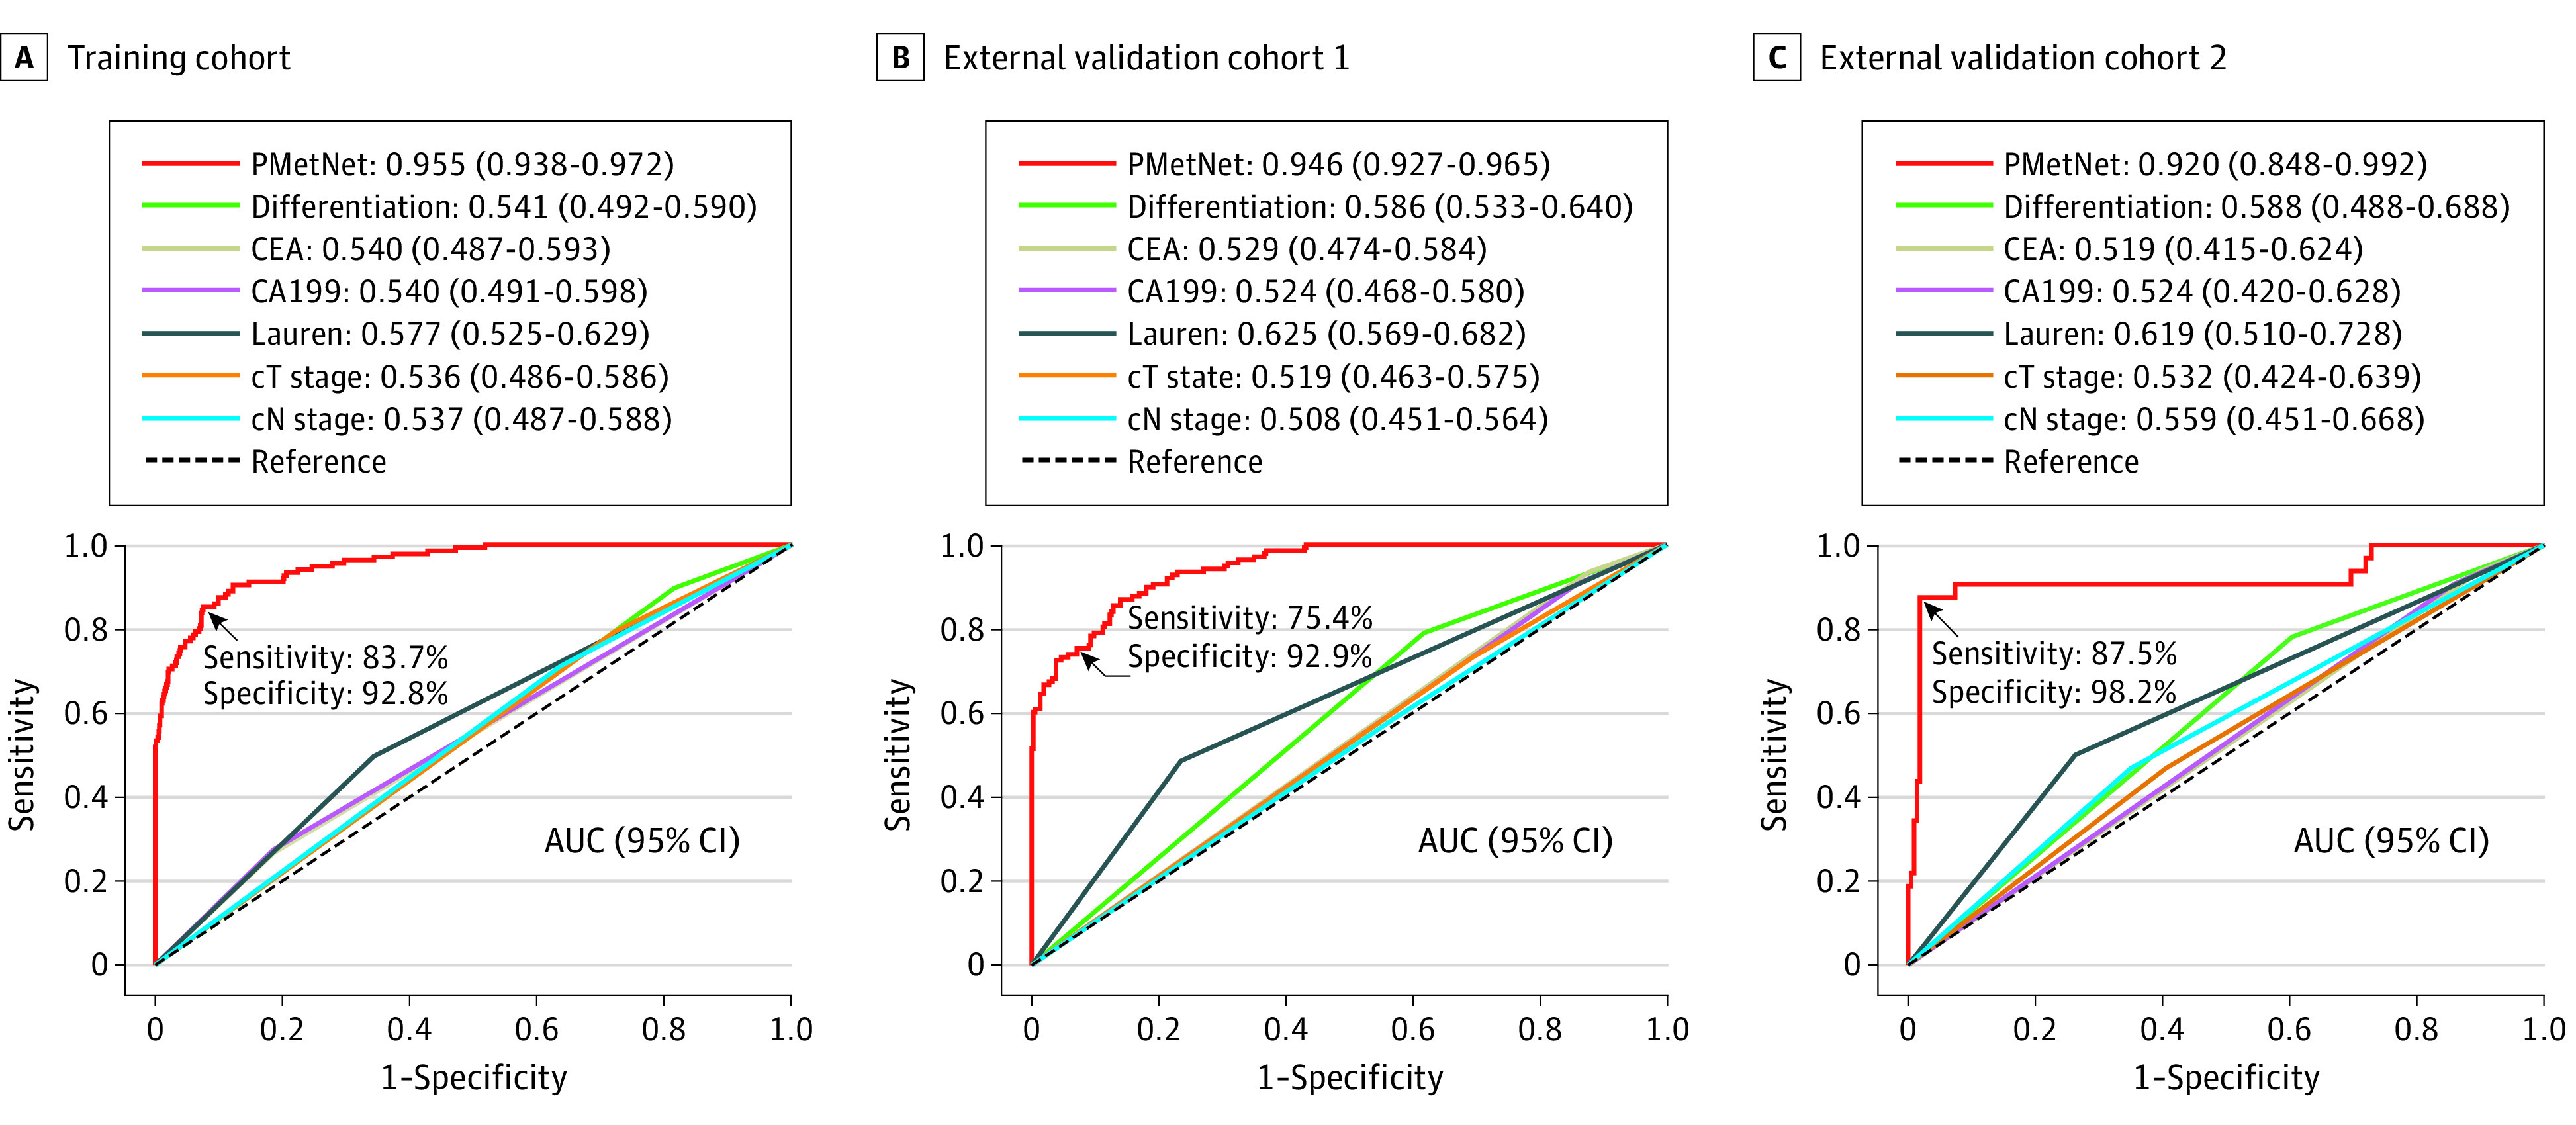
Area Under the Receiver Operating Characteristic Curves (AUCs) Derived From the Peritoneal Metastasis Network (PMetNet) and Clinicopathological Factors for the Diagnosis of Occult Peritoneal Metastasis in the Training and 2 Validation CohortsCA199 indicates cancer antigen 19-9; CEA, carcinoembryonic antigen.